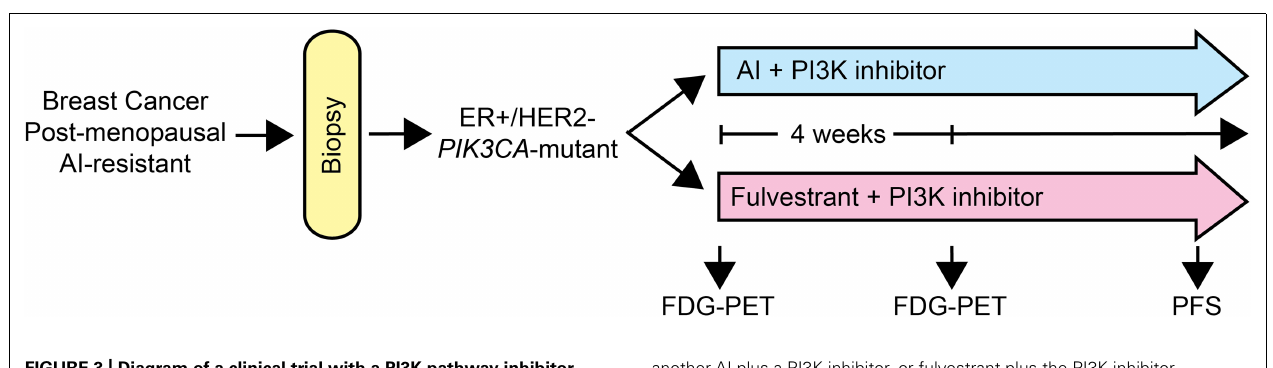
FIGURE 3 | Diagram of a clinical trial with a PI3K pathway inhibitor inAI-resistant breast cancer. Patients with breast cancer that progressed on AI therapy will be subjected to a biopsy to confirm ER + , HER2-negative, PIK3CA -mutant status. Eligible patients would then be randomized to